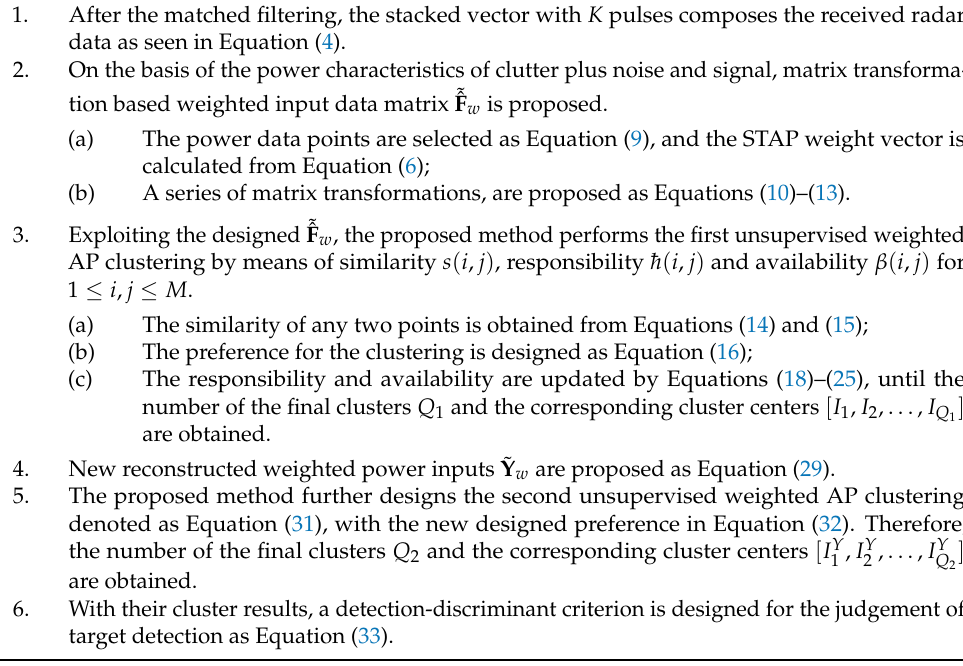
Table 1. The processing procedure of the proposed unsupervised